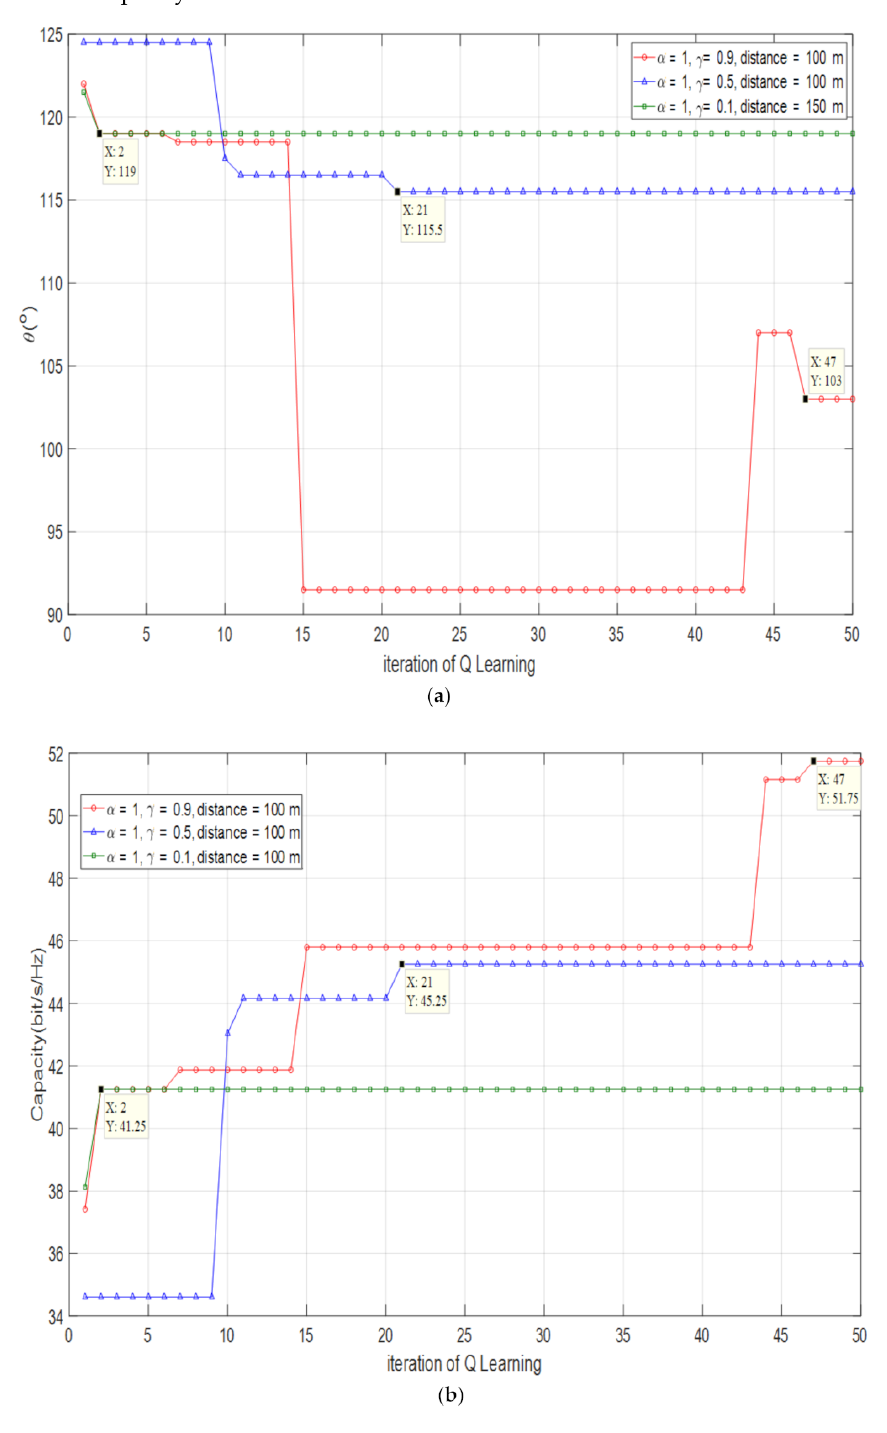
Figure 13. ( a ) Optimized antenna downtilt angle; ( b ) optimized channel capacity. D = 100 m, α = 1 with different γ